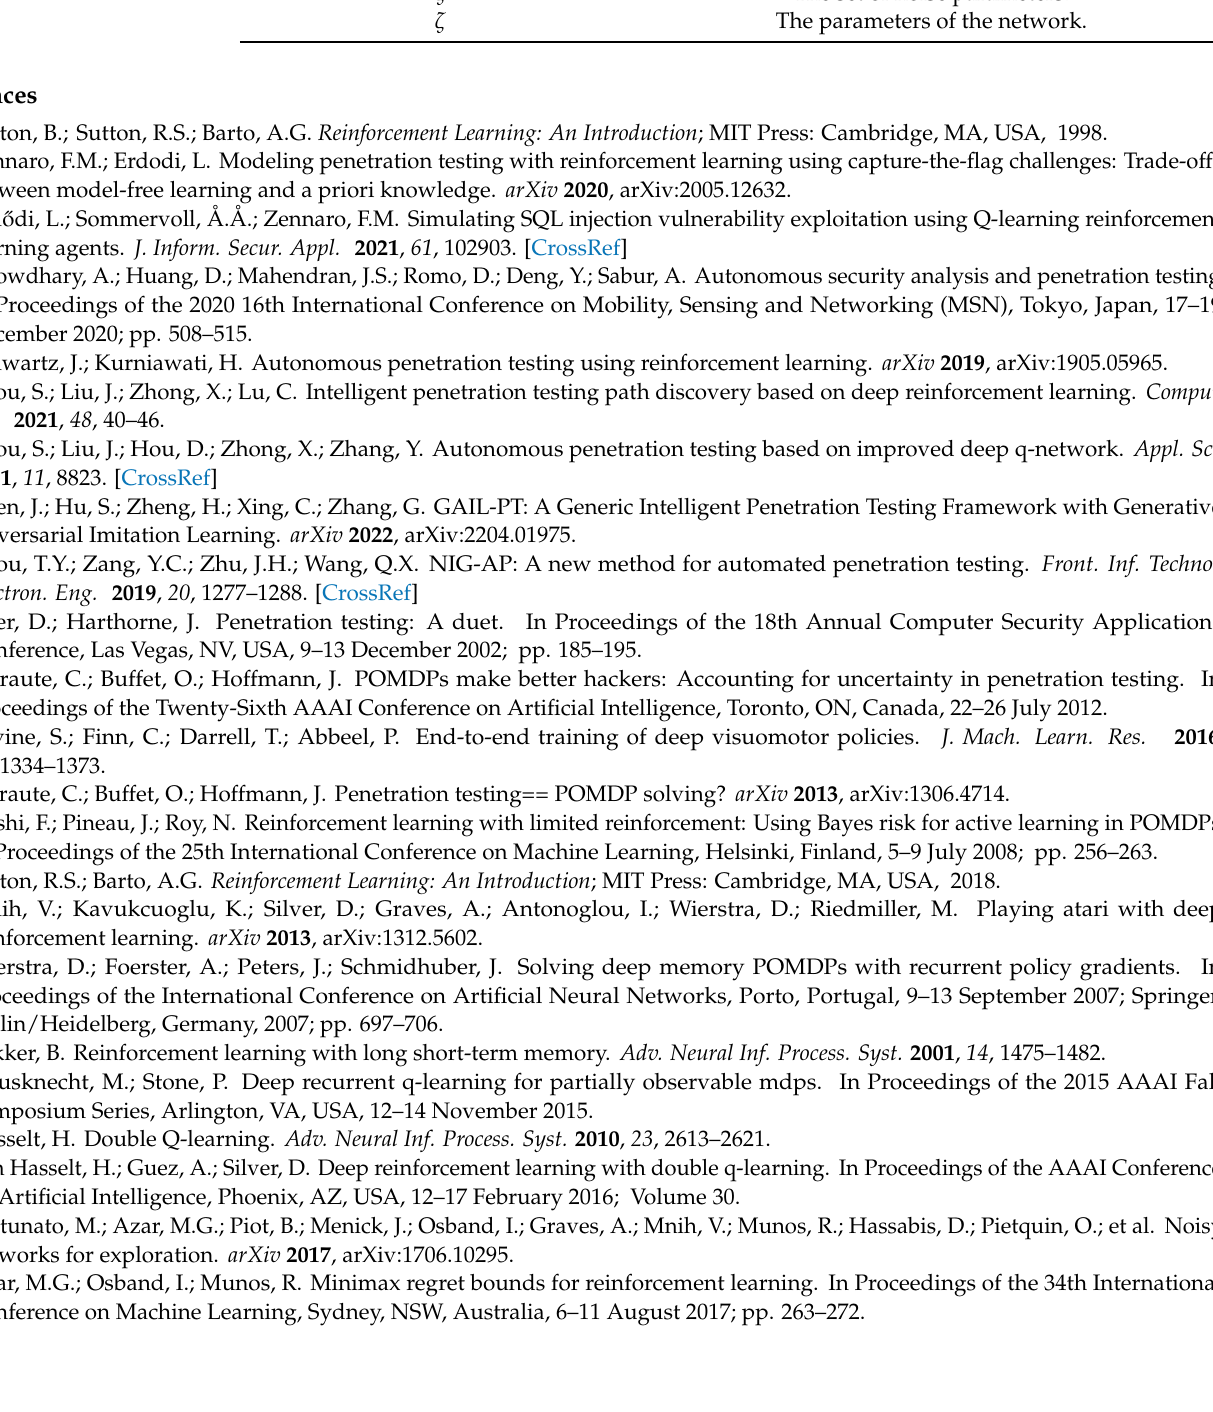
Table A1 describes the meaning of the symbols in the equations. Table A1. The meaning of the symbols in the equations. Symbol Mean ( µ , σ ) The learnable parameters in Noisy Nets. ε The static value. θ The noise parameters. ζ The linear composition of µ and σ . r The value of a reward. γ The discount factor. ξ The set of noise parameters. ζ The parameters of the